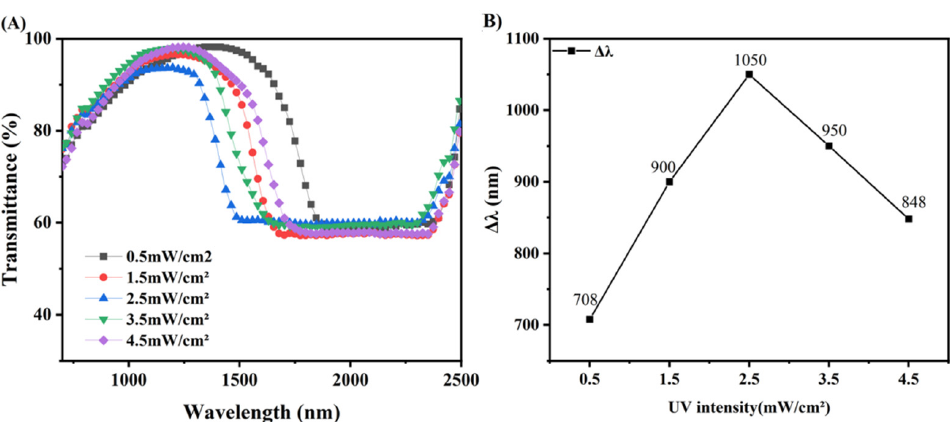
Figure 9. Transmission spectra ( A ) and Δλ for different UV intensities ( B ).